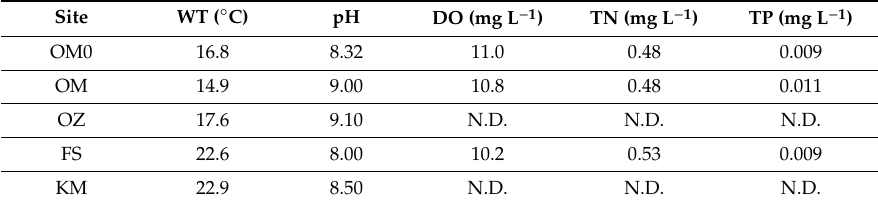
Table 2. Geochemical parameters of the present sampling